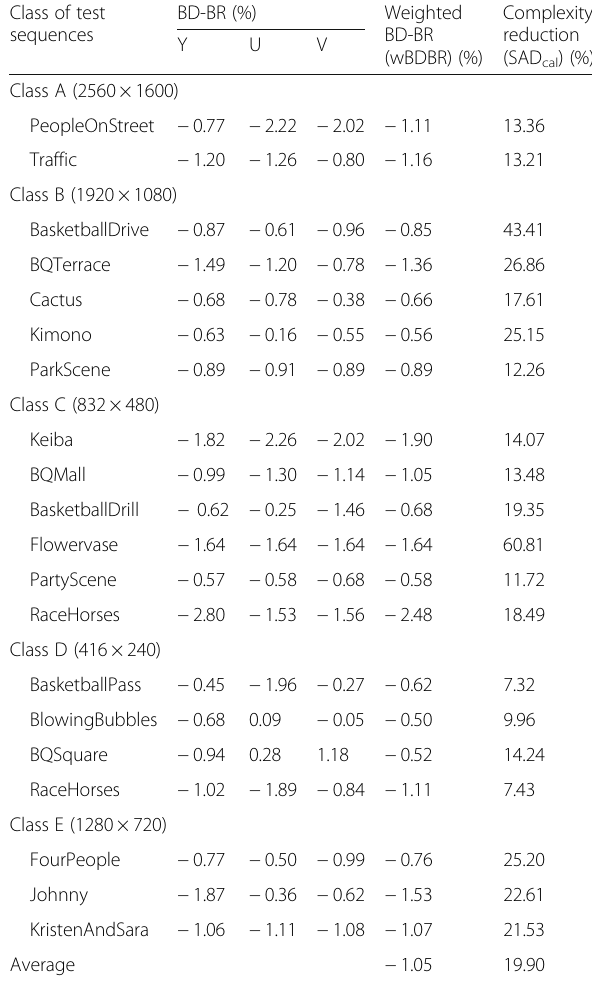
Table 1 The BD-BR values and complexity reduction results of the concurrent TZ